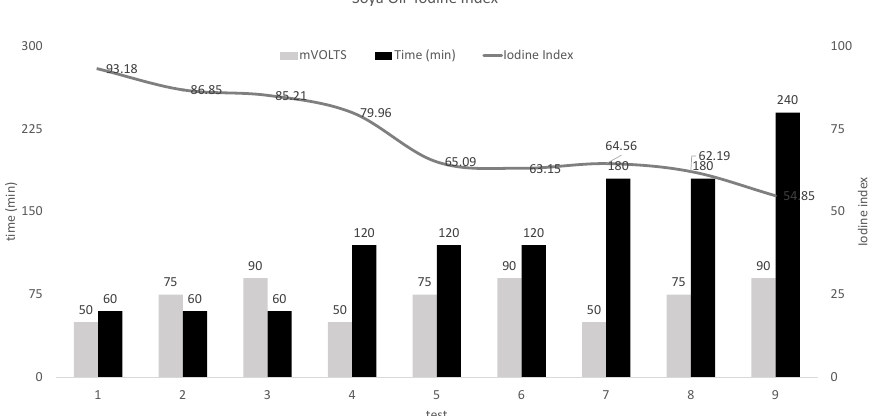
Figure 5. Percentage of iodine index vs. time and